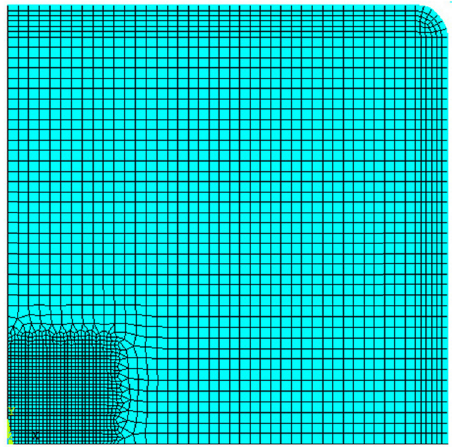
Figure 1: Two - dimensional heat transfer